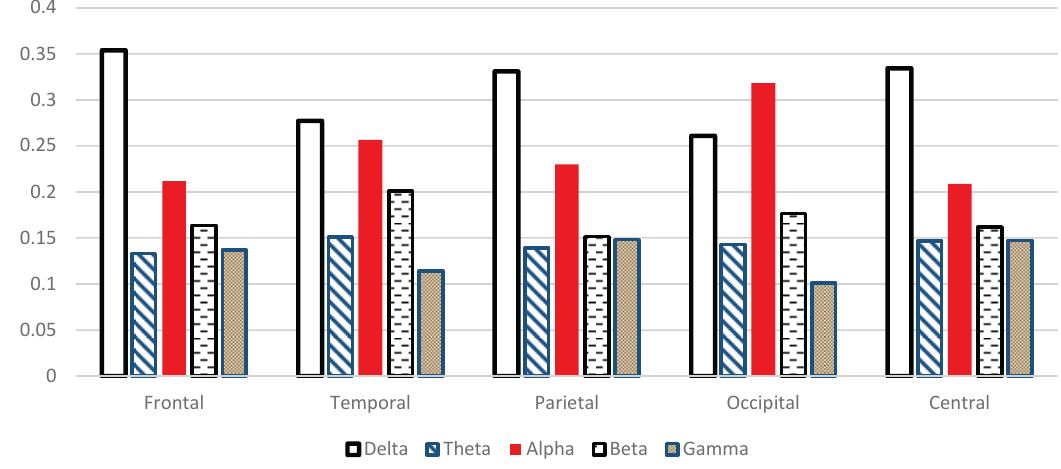
Figure 13. Comparative plot of the relative powers after using “sym9” wavelet filter for the five scalp regions of the brain for 10 control